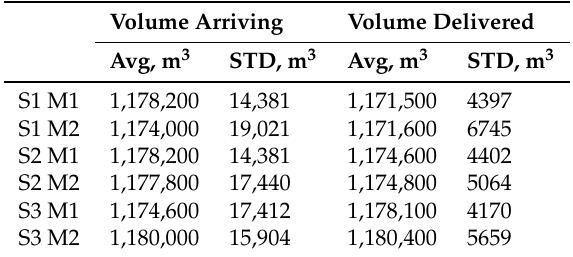
Table 2. Yearly volume of pulpwood arriving at the log-yard and delivered to the pulp mill under different scenarios. S x and M y denote the strategy and machine system used in the scenario, respectively.